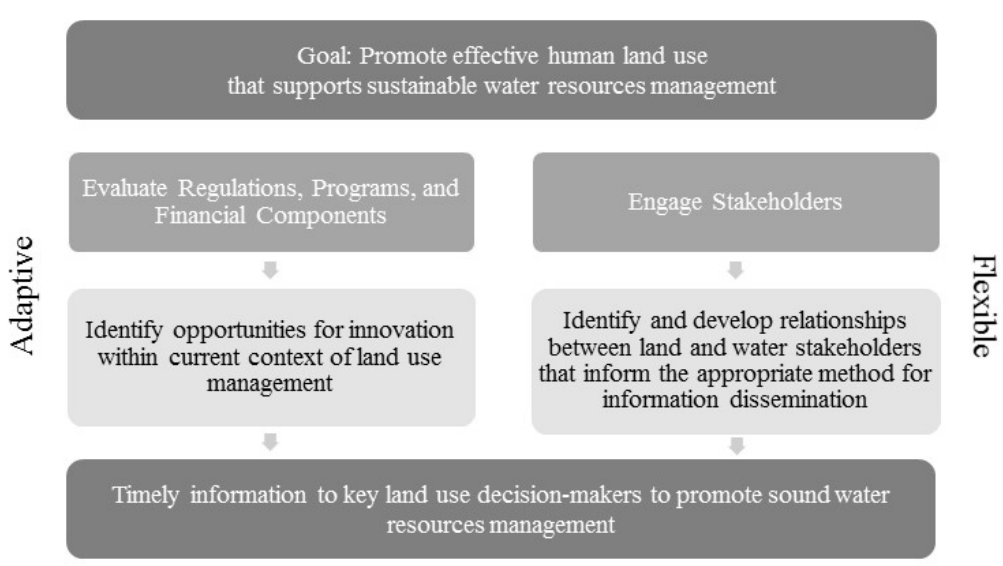
Figure 2. Method for integrating sound water resource management activities into land use decision-making in the Potomac basin.